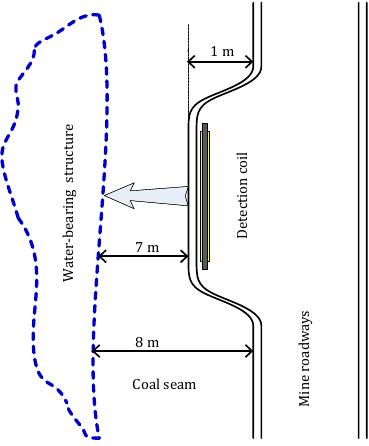
Figure 9. Schematic diagram of measurement site and known water-bearing structure.